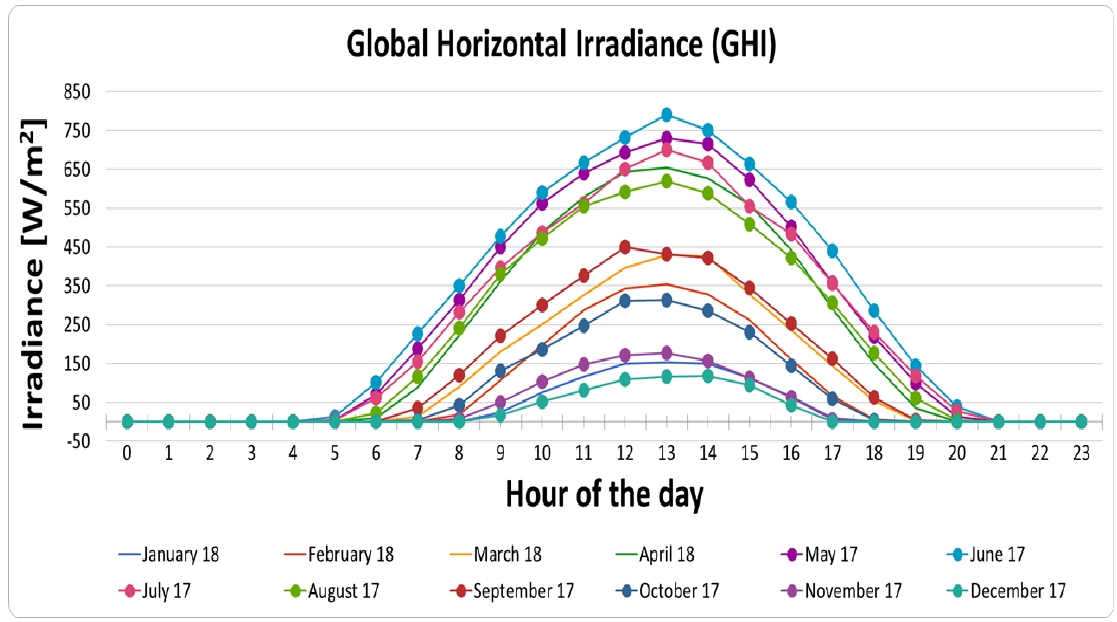
Figure 3. Global horizontal irradiation on a monthly basis given in 24 hours per day.